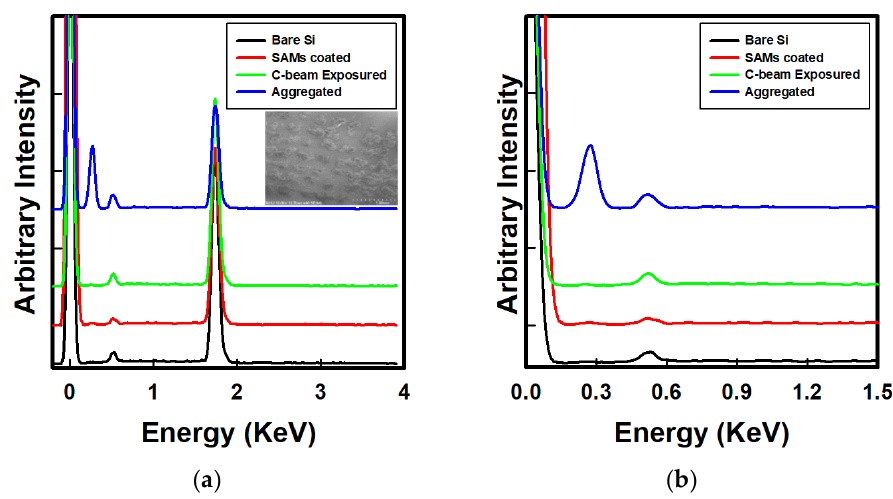
Figure 8. ( a ) EDX spectra of substrates after electron beam irradiation with 88-island emitter array on the designated positions, where aggregated carbon islands are visible in the inset. ( b ) Enlarged plot under 1.5 kV acceleration voltage.